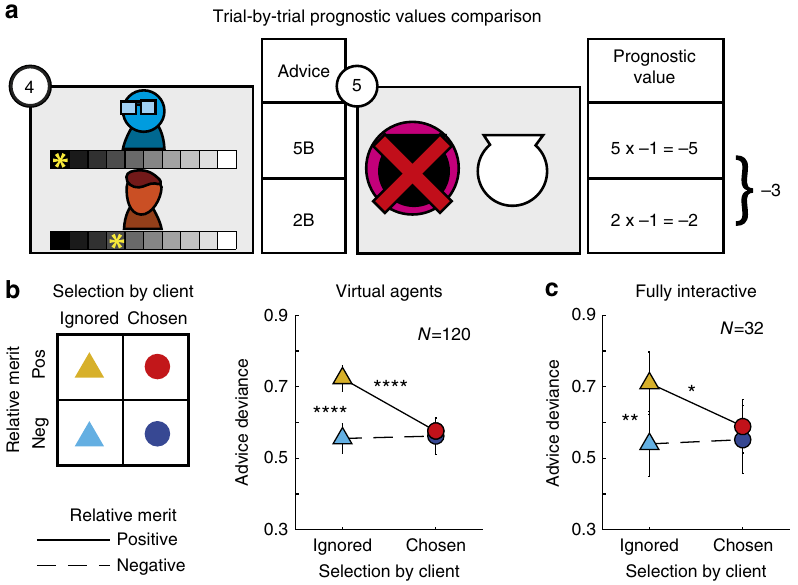
Fig. 3 Relative merit effect on advice. a At the end of each trial participants could evaluate and compare their and the rival ’ s advice prognostic value. The difference in prognostic value was accumulated to form the participants ’ relative merit. b Our best- fi tting model included a free parameter for accumulation rate for differences in prognostic values, for relative merit and for the interaction between merit and client ’ s selection. We used the individual estimated parameters to evaluate the trial by trial relative merit and divided the trials to four conditions according to the selection by client and relative merit variables. Advice deviance was highest (i.e., most overcon fi dent) when participants ’ positive relative merit con fl icted with the client ’ s choice to ignore them and demonstrated a signi fi cant interaction effect. c The same pattern of behaviour was replicated in the fully interactive experiment, where three human participants played the roles of a client and two advisers (two-tailed paired t -test comparisons: * P < 0.05, ** P < 0.005, **** P < 0.00005, error bars indicate